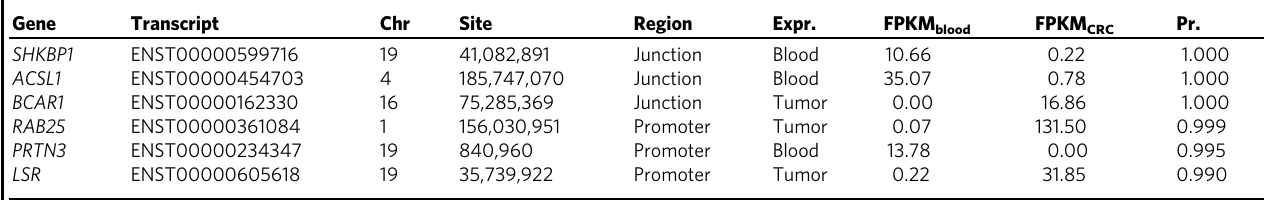
Table 1 NDR features predictive of ctDNA fraction in